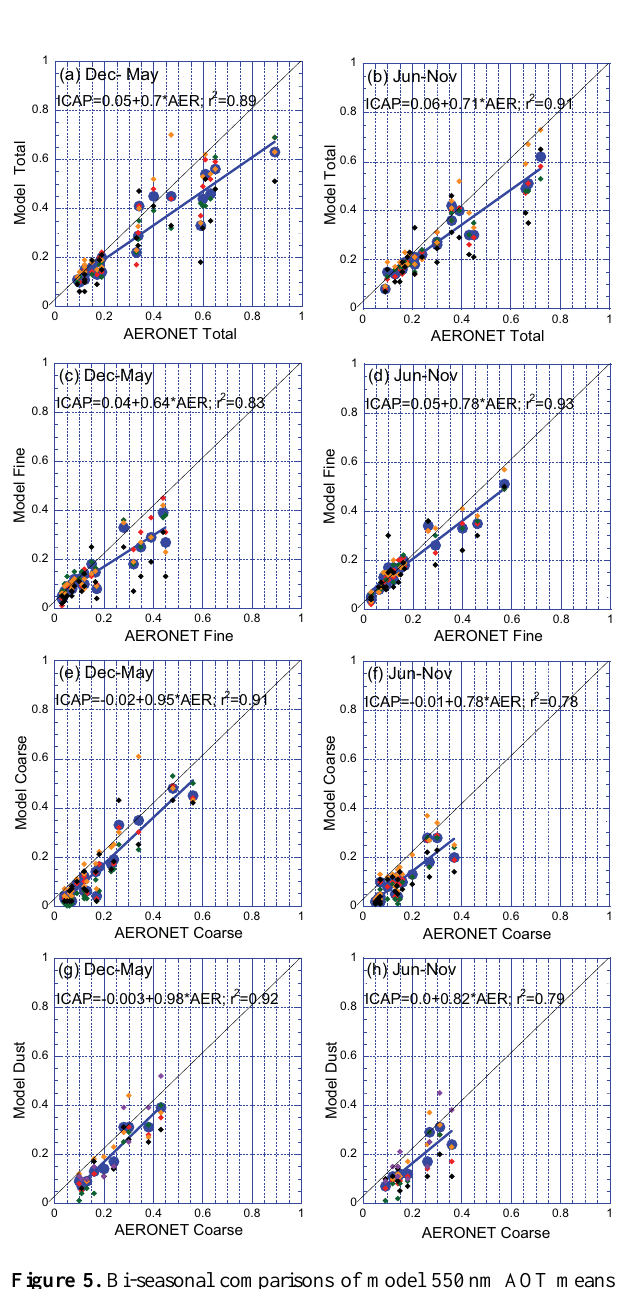
Figure 5. Bi-seasonal comparisons of model 550nm AOT means with 21 core AERONET verification sites listed in Table 1. Large blue circles are ICAP-MME means. Other models are small col- ored diamonds. Data are stratified (left column) for December– May 2011, (right column) June–November. (a) and (b) core models and ensemble mean comparisons to total AERONET derived 550 nm AOT. (c) and (d) models vs. AERONET for fine mode parti- cles. (e) and (f) models vs. AERONET for coarse mode particles. (g) and (h) model dust vs. AERONET Coarse for dust stations listed in Table 2. NGAC is included in the dust comparison.